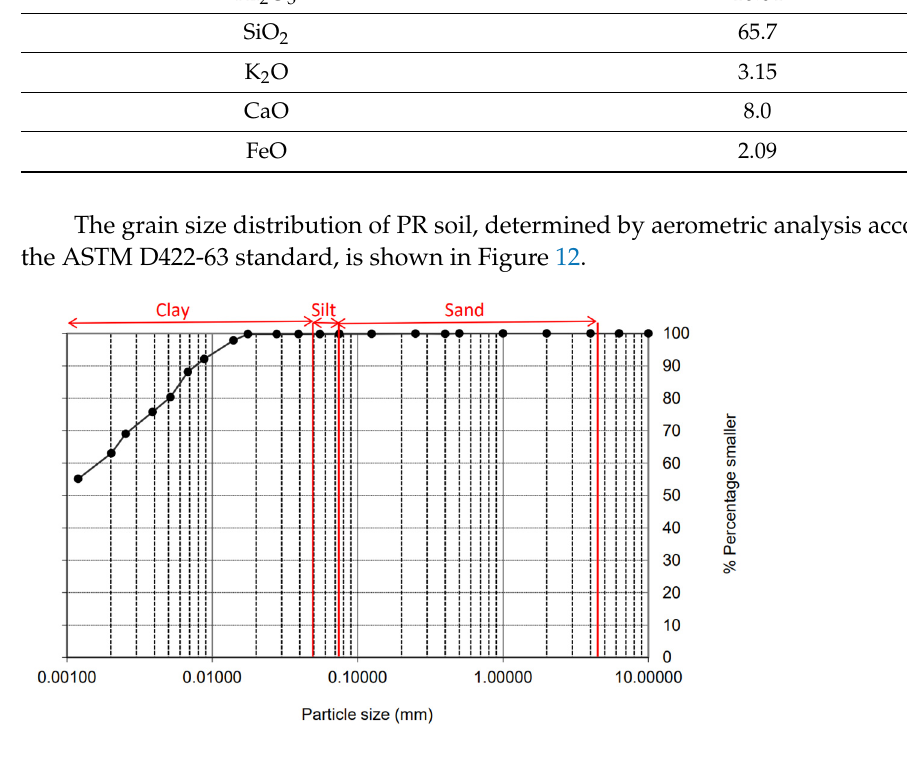
Figure 12. Grain size distribution of PR soil.